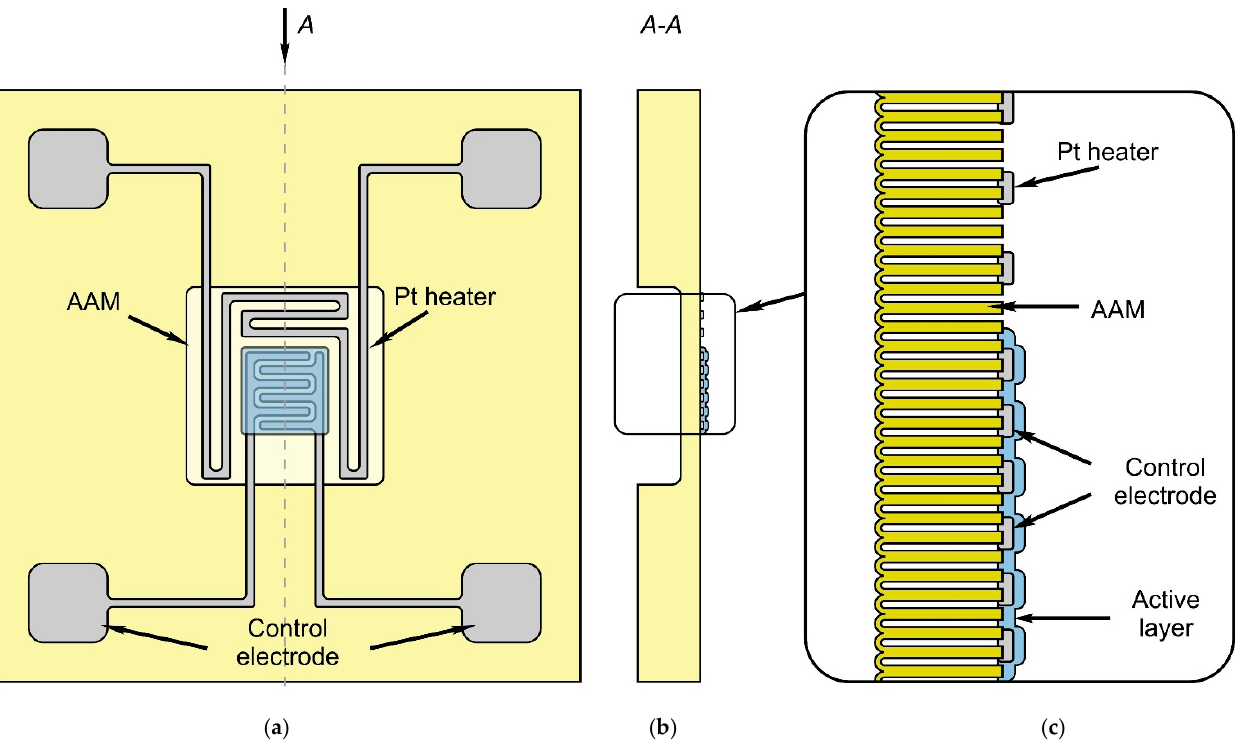
Figure 2. Schematic representation of a gas sensor based on a profiled substrate with a thin AA membrane ( a ); schematic cross-sectional view of the sensor in the middle of the membrane ( b ); design of a platinum heating element covered with a SiO 2 /Si 3 N 4 dielectric bilayer ( b ); enlarged image of the insert with detailed cross-sectional view of the sensor elements ( c ).